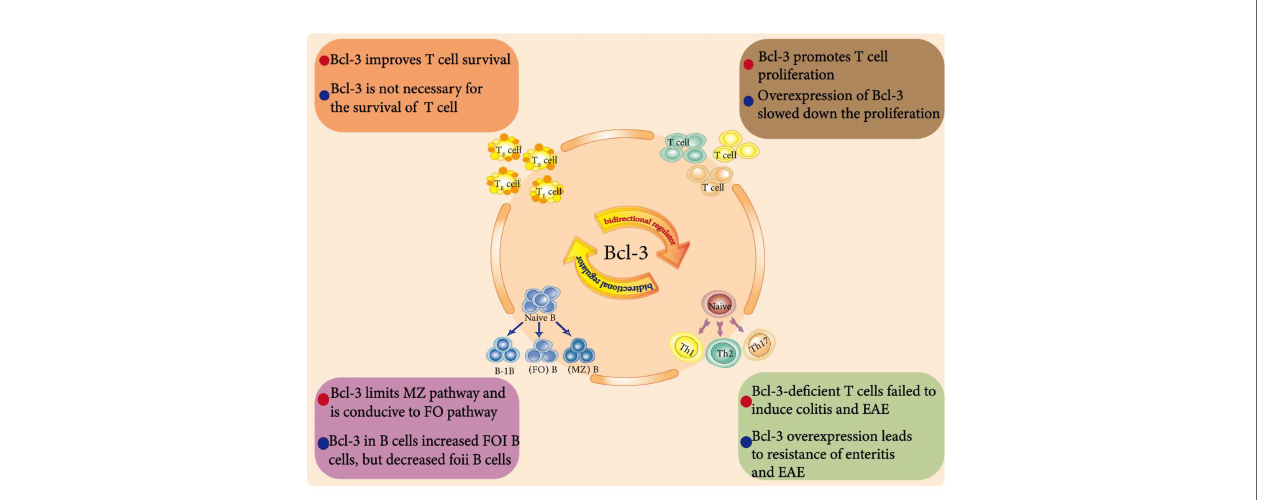
FIGURE 4 | Bcl-3 as a bidirectional regulator in immune cells. Endogenous Bcl-3 is crucial for the development and function of B cells. For example, Bcl-3 regulates the development of splenic B cells. It limits the development of marginal zone (MZ) B cells but is conducive to the development of follicular (FO) B cells. In addition, Bcl-3 is an environment-dependent T cell response regulator that affects T cell survival, differentiation and proliferation and plays a dual regulatory role in